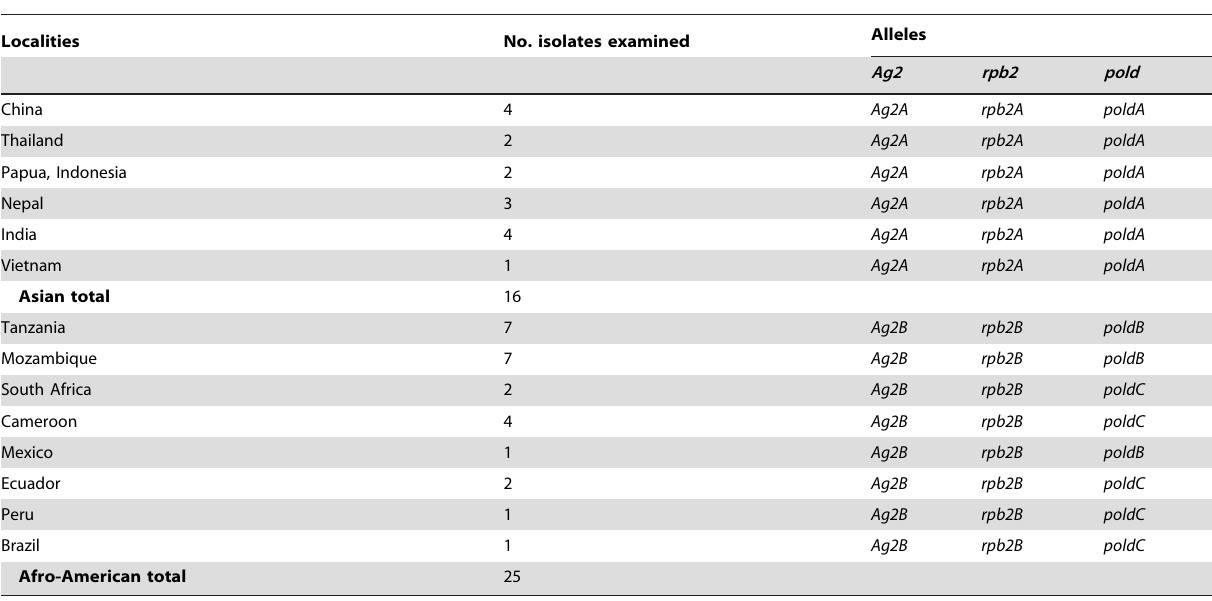
Table 3. Distribution of alleles at each nuclear locus around the world.